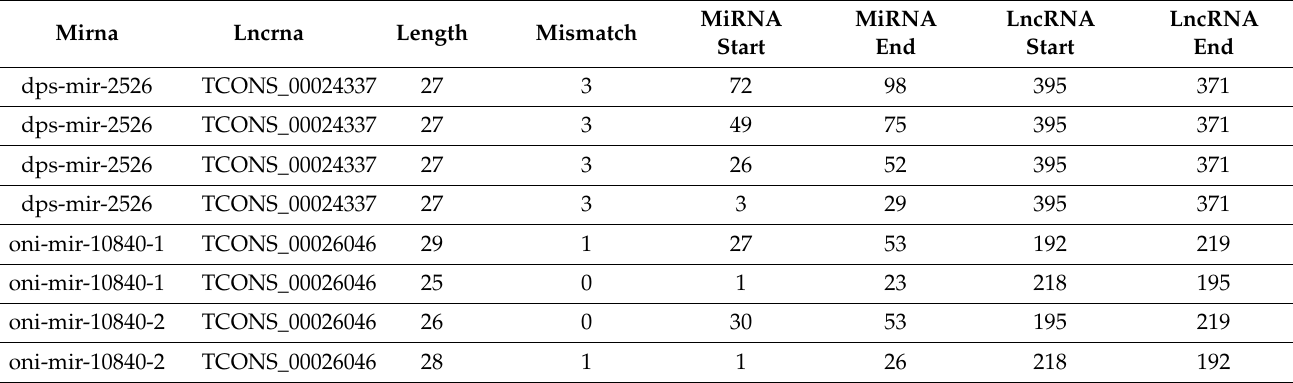
Table 5. MiRNAs targeting identified